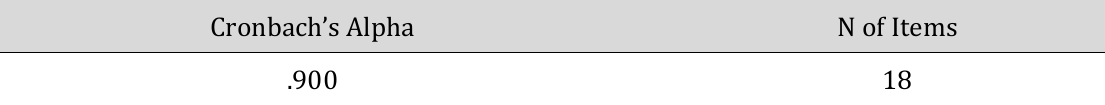
Table 9. The reliability test results of students’ writing motivation